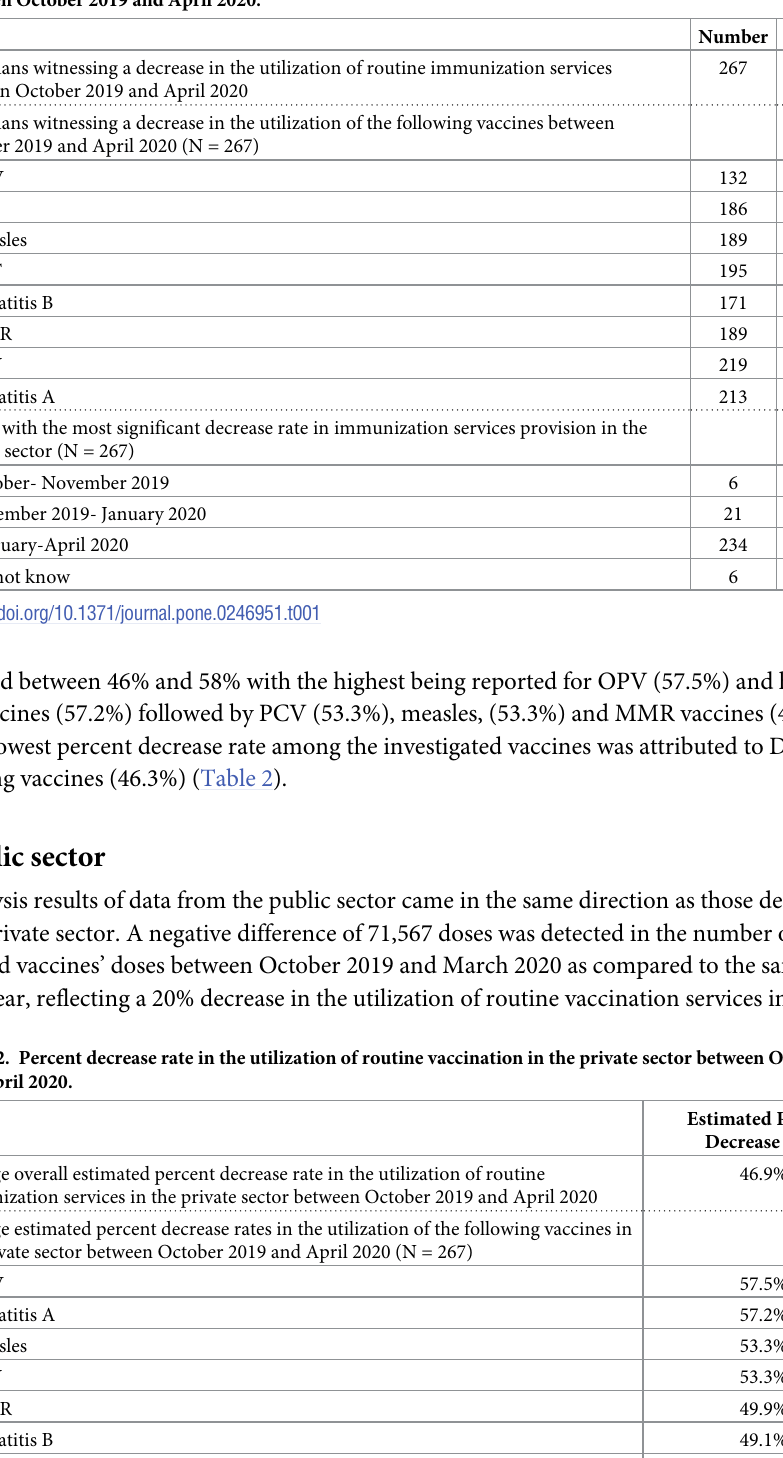
Table 1. Witnessed decrease among private physicians in the utilization of routine immunization services between October 2019 and April